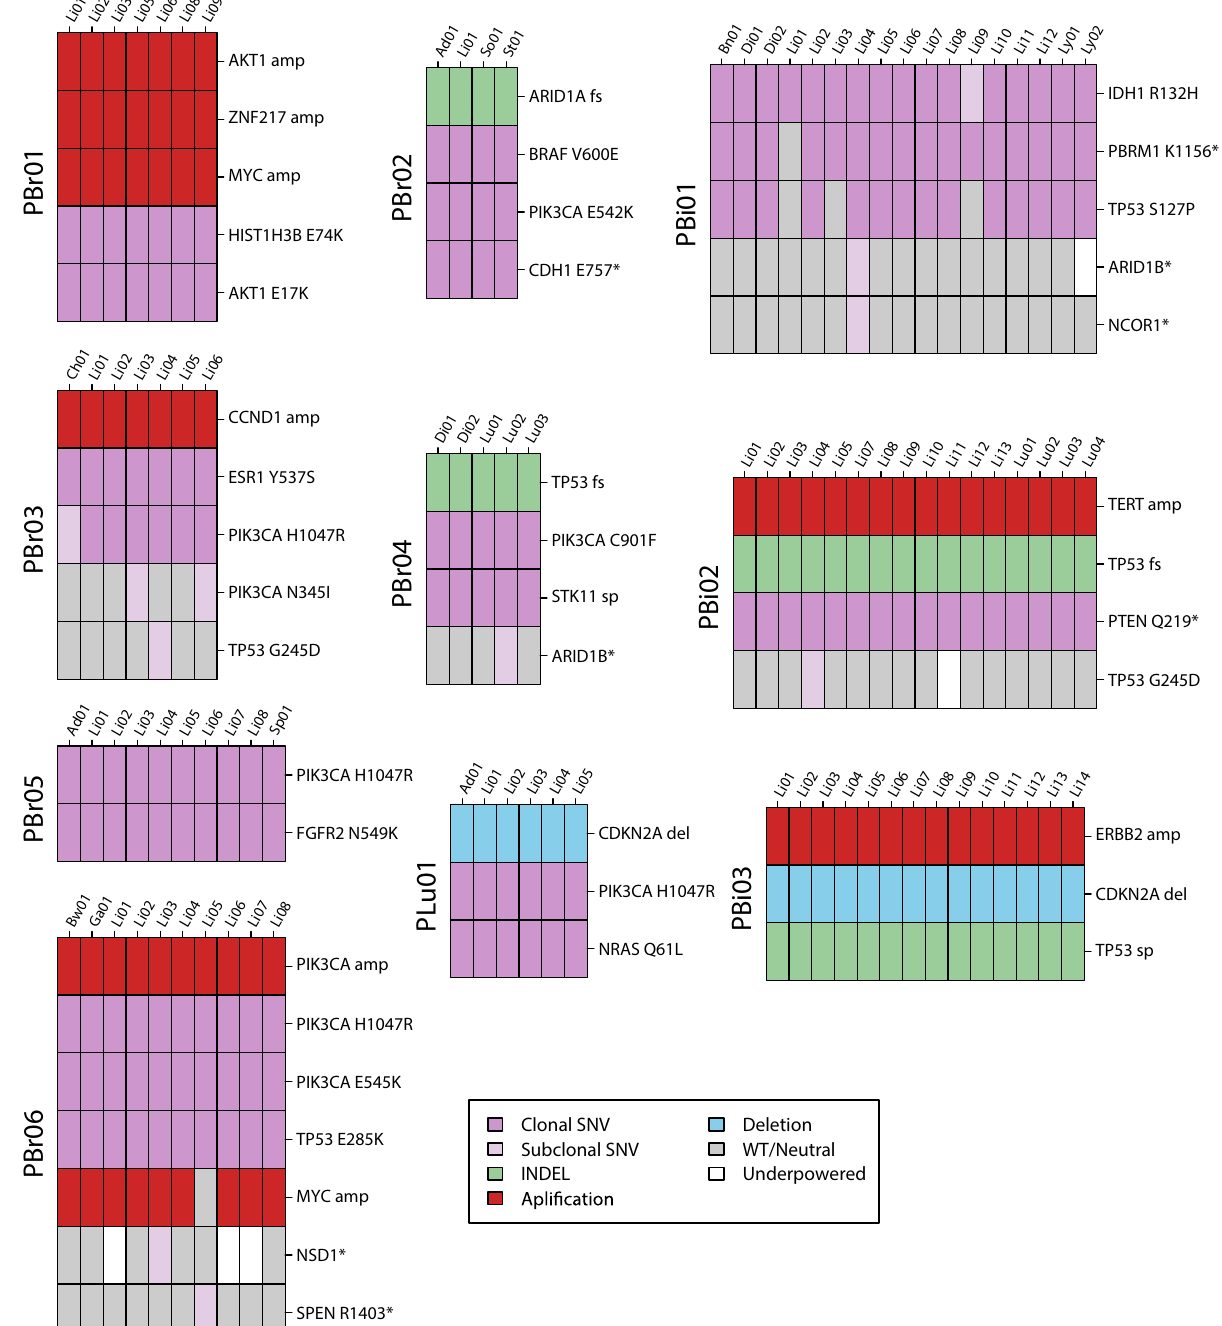
Fig. 2 Functional alterations in ten pretreated metastatic cancer. The driver alterations ( “ Methods ” ) present in each sample are depicted by colored bars. Cancer cell fractions (CCF) of somatic SNVs are indicated by color intensity. Copy number changes depicted include high-level ampli fi cations (amp) and deletions (loss). Gray bars indicate wild-type/copy neutral states for a particular sample. White bars indicate loci where there was not suf fi cient power to detect the speci fi ed mutation in a lesion ( “ Methods ” ). * nonsense SNV, fs frameshift indel, sp splice-site cfDNA across all patients (range = 15.8 – 87.5%, excluding PBr02). cfDNA. At least 90% power was available to detect mutations To determine whether we were powered to detect mutations present in a minimum ctDNA CCF of between 0.05 present in cfDNA, we used the estimate circulating tumor DNA (PBr05) – 0.175 (PBi01) with a median minimum ctDNA CCF (ctDNA) fraction in cfDNA to calculate the power for mutation of 0.08 across all samples (Fig. 4B). We detected fewer than 40% detection across a range of ctDNA CCFs for each liquid biopsy of non-truncal mutations observed in tissue samples from PBr06, (Supplementary Fig. 12). Power calculations were based on the despite the relatively high power available in the plasma sample median depth of coverage in tissue samples across loci, where from this patient (90% power achieved at ctDNA CCF ≥ 0.08). In branch and private mutations were detected in tissue but not in addition, non-truncal mutation detection was higher in PBr03 (4/